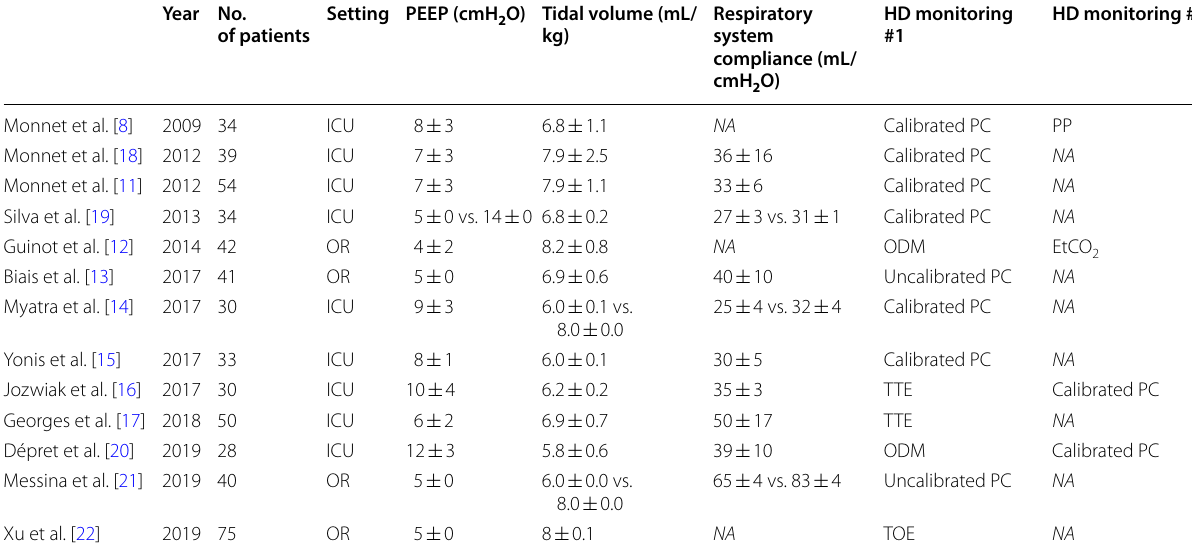
EtCO 2 end-tidal carbon dioxide, HD haemodynamic, ICU intensive care unit, NA not available, ODM oesophageal Doppler monitoring, OR operating room, PC pulse contour, PEEP positive end-expiratory pressure, TOE trans-oesophageal echocardiography, TTE trans-thoracic echocardiography